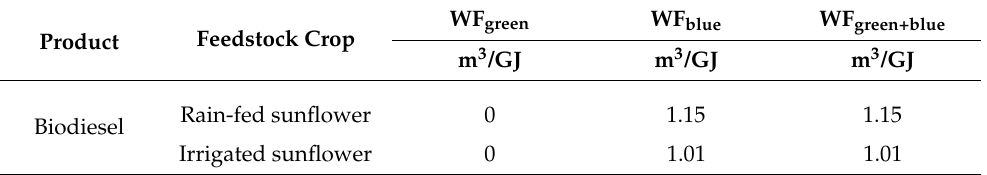
Table 5. Water footprint per GJ of biodiesel (processing